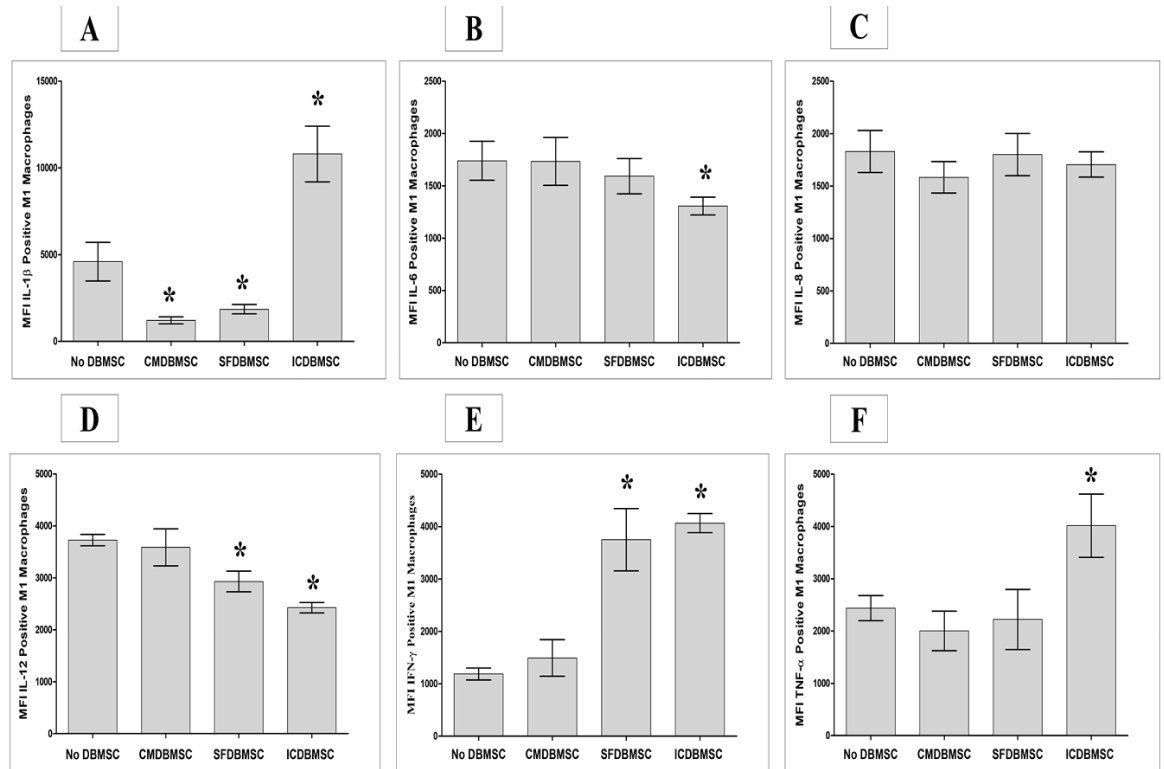
Figure 5. Effects of human DBMSCs on expression of the intracellular cytokines IL-1 β , IL-6, IL-8, IL-12, IFN- γ , and TNF- α by human monocytes differentiated into macrophages by GM-CSF, as analyzed by flow cytometry. After six days in culture, compared to untreated macrophages, CMDBMSCs significantly decreased expression of IL-1 β ( A ) by macrophages while having no significant effects ( p > 0.05) on expression of IL-6 ( B ), IL-8 ( C ), IL-12 ( D ), IFN- γ ( E ), and TNF- α ( F ) by macrophages. Compared to untreated macrophages, SFDBMSCs significantly decreased expression of IL-1 β ( A ) and IL-12 ( D ) while having no significant effects ( p > 0.05) on expression of IL-6 ( B ), IL-8 ( C ), and TNF- α ( F ), but significantly increasing expression of IFN- γ ( E ) by macrophages. In addition, compared to untreated macrophages, ICDBMSCs significantly increased expression of IL-1 β ( A ), IFN- γ ( E ), and TNF- α ( F ) while decreasing IL-6 ( B ) and IL-12 ( D ), but having no significant effects ( p > 0.05) on expression of IL-8 ( C ) by macrophages. Levels of expression are presented as median fluorescent intensity (MFI) as determined by flow cytometry. Experiments were carried out in duplicate and repeated 30 times using 30 individual preparations of both monocyte-derived macrophages and DBMSCs. * p < 0.05. Bars represent standard